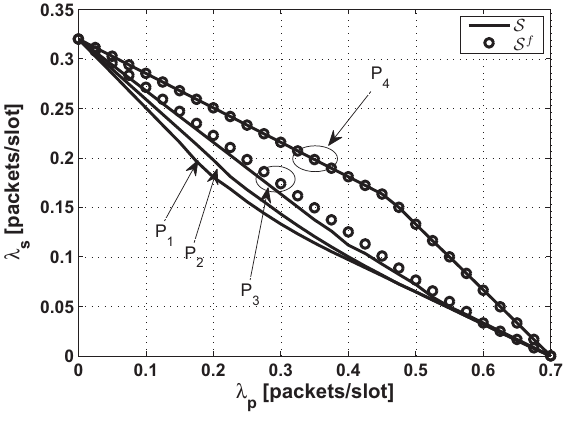
Figure 6. Stability region of the proposed